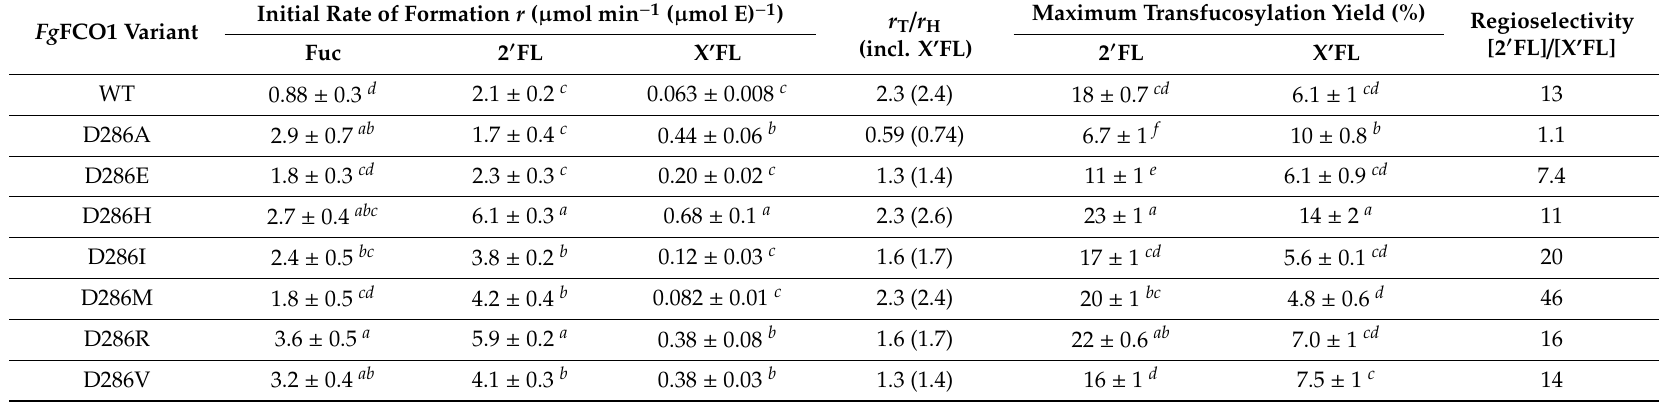
Table 4. Transfucosylation with depolymerized xyloglucan donor substrate. Initial rates of formation ( r ) of fucose (Fuc), 2 (cid:48) -fucosyllactose (2 (cid:48) FL), and its regioisomer X’FL in the transfucosylation catalyzed by Fg FCO1 site-saturation mutagenesis variants of D286 using XEG-treated fucosylated citrus peel xyloglucan as fucosyl donor and lactose as an acceptor over 24 h. The ratio between the transfucosylation rate ( r T ) and the hydrolysis rate ( r H ) is indicated: the first number is calculated for 2’FL alone, whereas the number in brackets includes the sum of FL isomers. Maximum molar yields on the donor substrate obtained during the 24 h of reaction are given for 2 (cid:48) FL and X’FL.Superscript letters ( a – e ) indicate significant di ff erences between enzyme variants for each rate of formation or for yield of each product ( p <